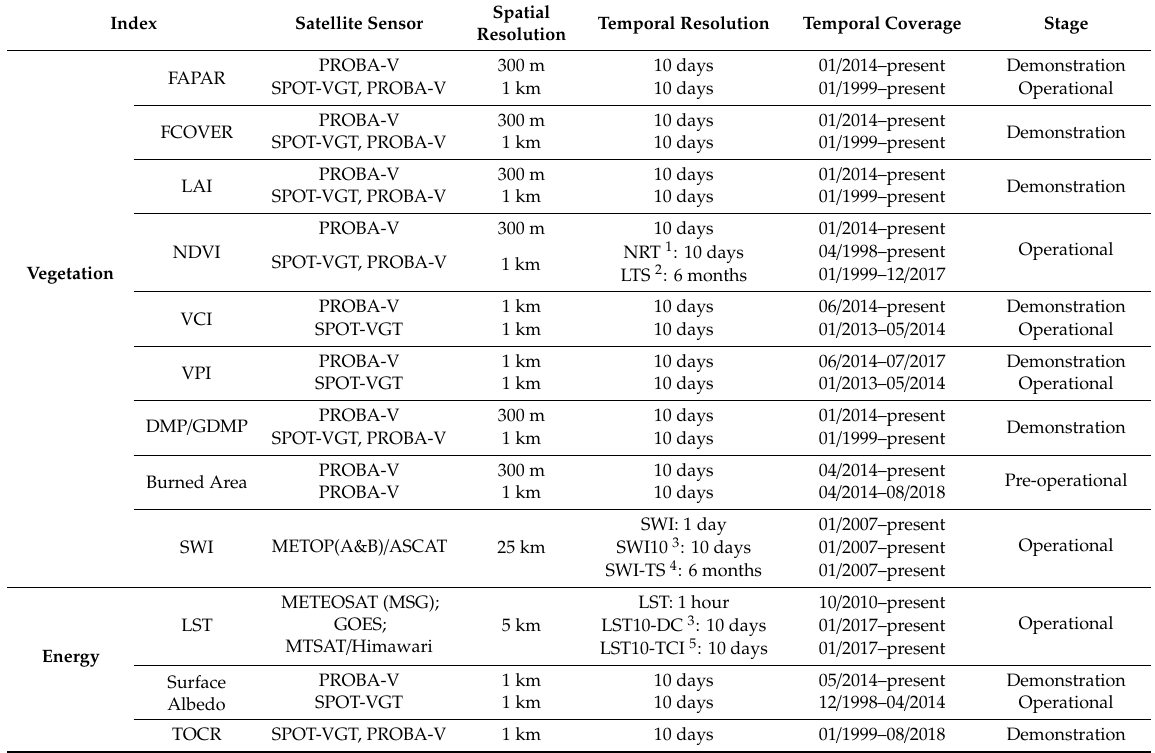
Table 3. Main characteristics of the last-updated versions of the bio-geophysical indices considered in the literature review, provided by the Copernicus Global Land Service (CGLS) through its vegetation and energy products [40] (as of November